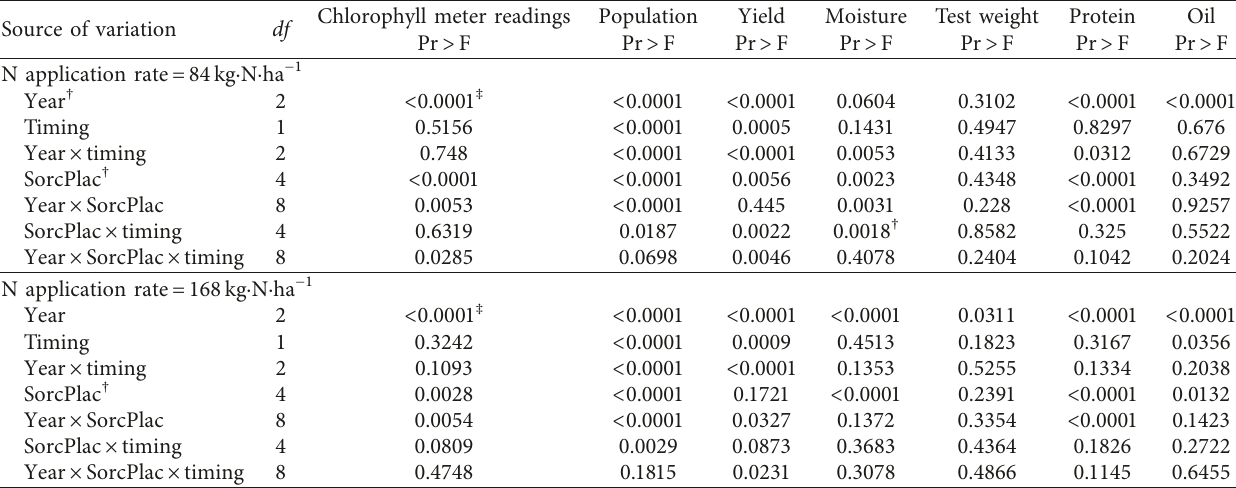
Table 3: The ANOVA table for chlorophyll meter readings, plant population, yield, moisture, test weight, starch, protein, and oil con- centration for nitrogen treatments at 84 and 168kg · N · ha − 1 .